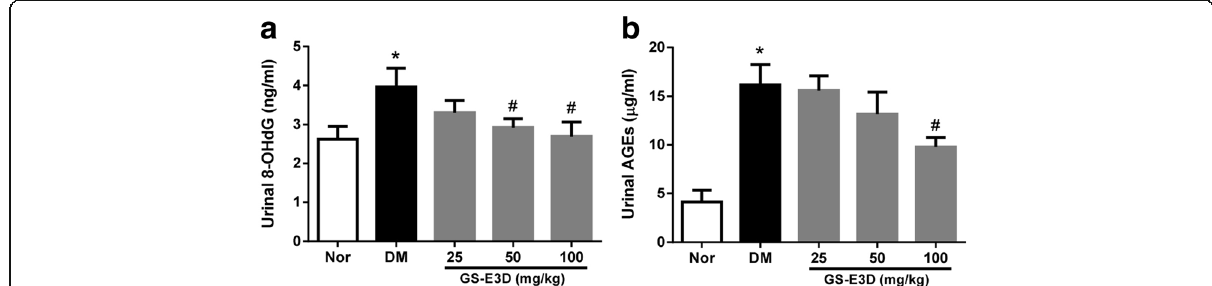
Fig. 2 Urinary excretion of 8-hydroxy-2 ′ -deoxyguanosine (8-OHdG) and advanced glycation end-products (AGEs). The urine levels of 8-OHdG ( a ) and AGEs ( b ) were determined by enzyme-linked immunosorbent assays. NOR, normal rat; DM, streptozotocin-induced diabetic rat; GS-E3D, DM treated with the indicated dose of GS-E3D. All data were expressed as mean ± the standard error of the mean ( n = 8); * p < 0.05 vs. NOR group; # p < 0.05 vs. DM group